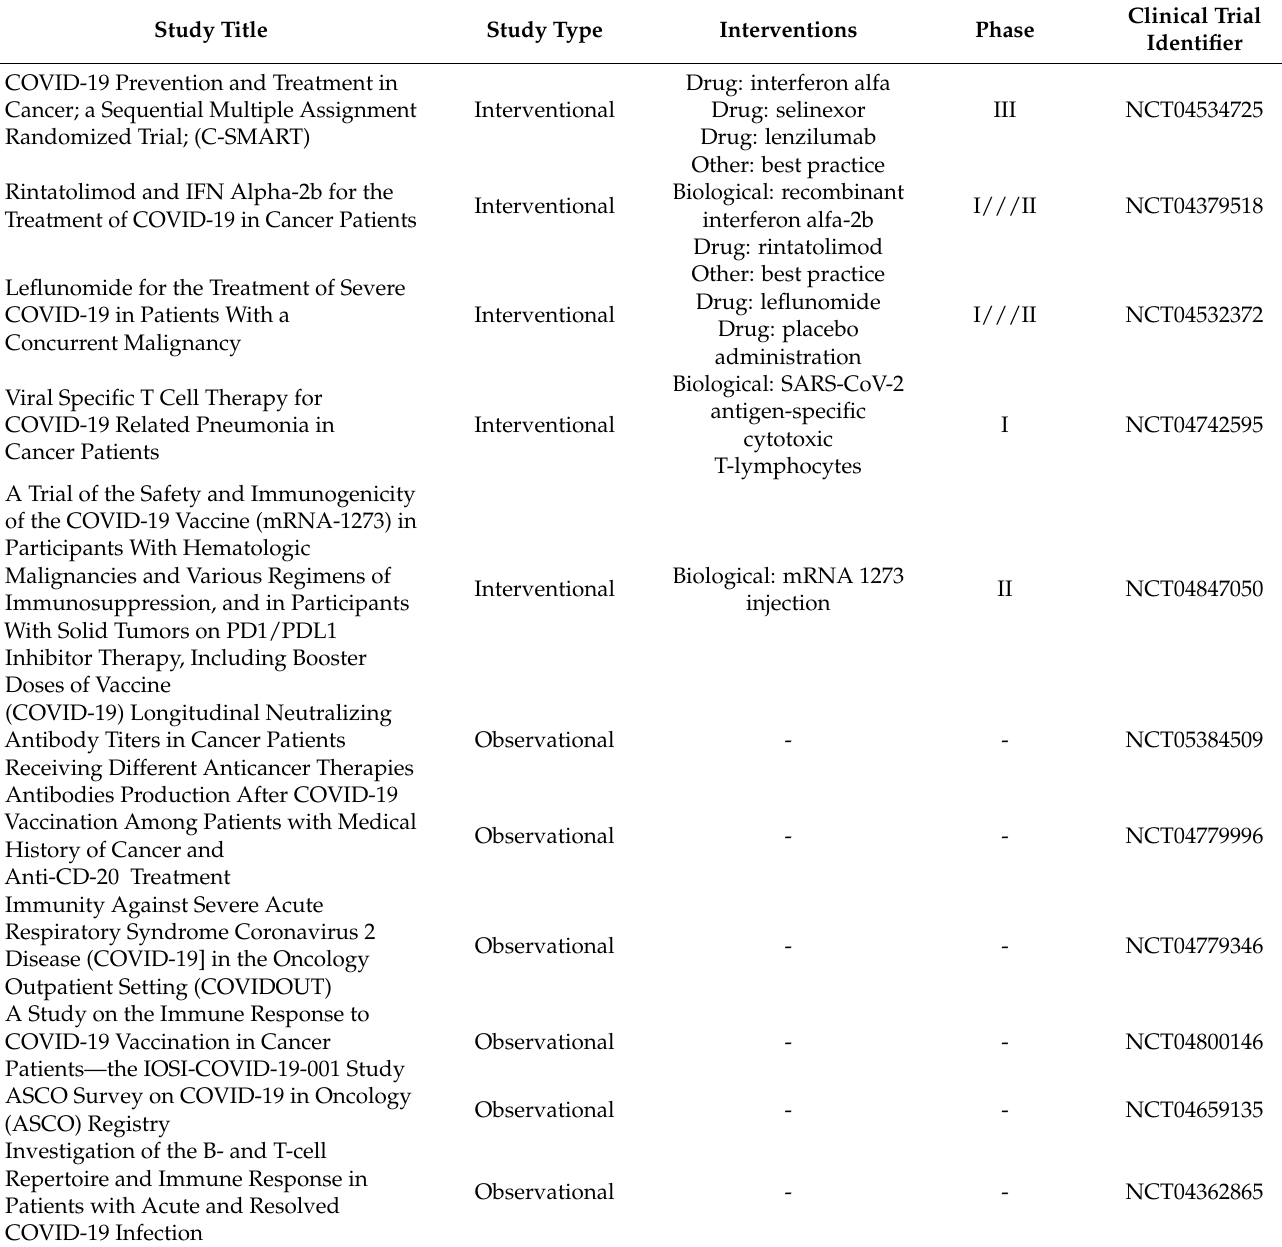
Table 1. Selected ongoing studies on COVID-19 and cancer (interventional and observational). Source: clinicaltrials.gov. accessed on 2 October